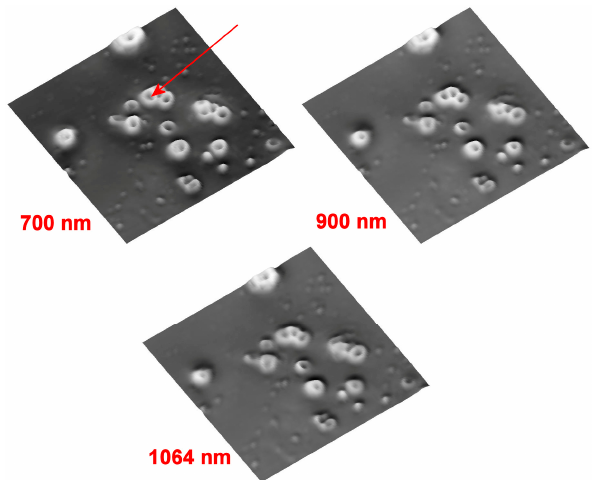
Figure 4. Reflectance HSCM image of a blood sample at 700 nm, 900 nm and 1064 nm, respectively. The overall intensities have been inverted to render the image more understandable. The red arrow shows the point where detailed plots are then given. The images, three of about 1000 acquired simultaneously, have a lateral size of 150 µ m and are made by 512 × 512 pts 2